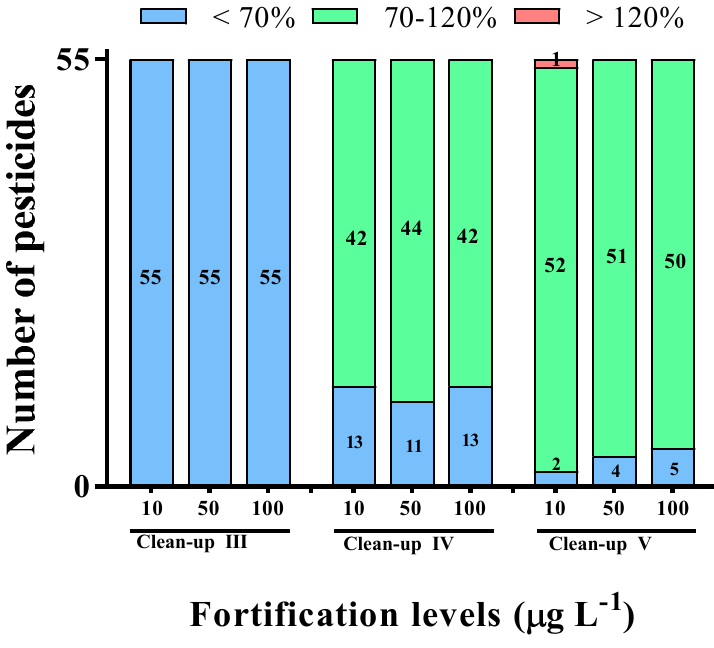
Figure 3. The recoveries of different clean-up procedures for LC-MS/MS at the spiked level of 10, 50, and 100 μ g L − 1 . The different clean-up procedures used were as follows: Clean-up Ⅲ (50 mg GCB, 50 mg PSA, and 150 mg MgSO 4 ); Clean-up Ⅳ (50 mg Z-Sep, 50 mg PSA, and 150 mg MgSO 4 ); Clean-up Ⅴ (7.5 mg ENVI-Carb, 25 mg PSA, and 150 mg MgSO 4 ).